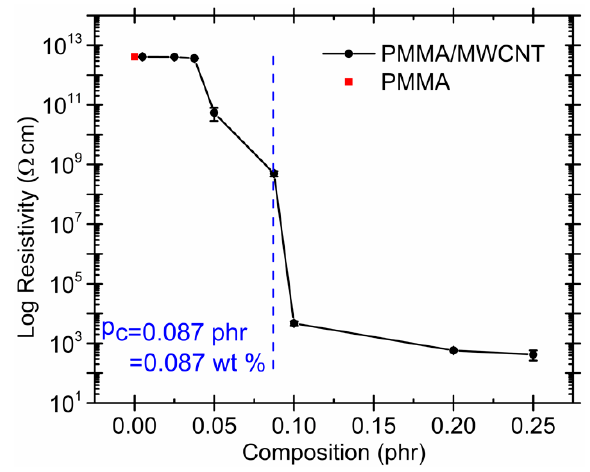
Figure 3. Percolation curve of MWCNT / poly(methyl methacrylate) (PMMA) made using mechanical mixing. Modified from [9].